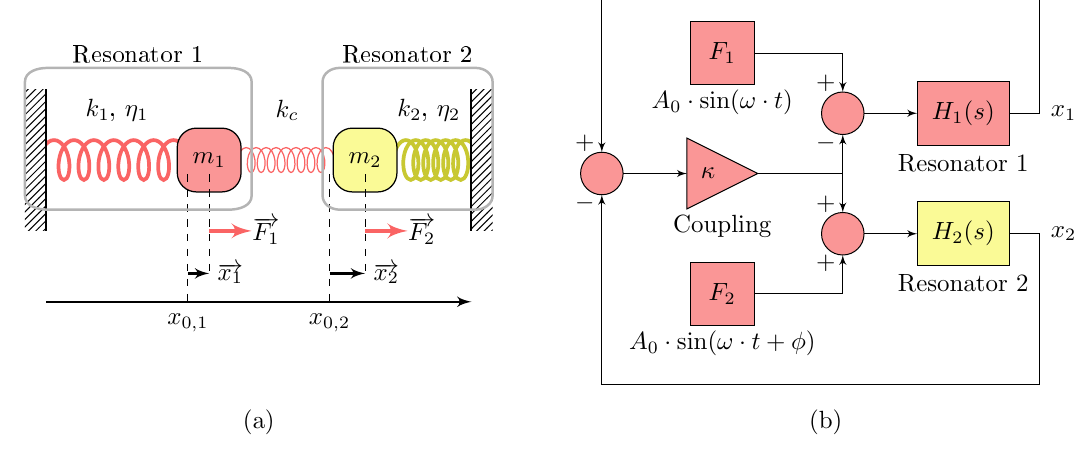
Figure 1. Two coupled resonators having linear stiffness k i and damping η i , where κ = k c ( a ): Mass-spring like coupled resonators ( b ): Equivalent block diagram of ( a